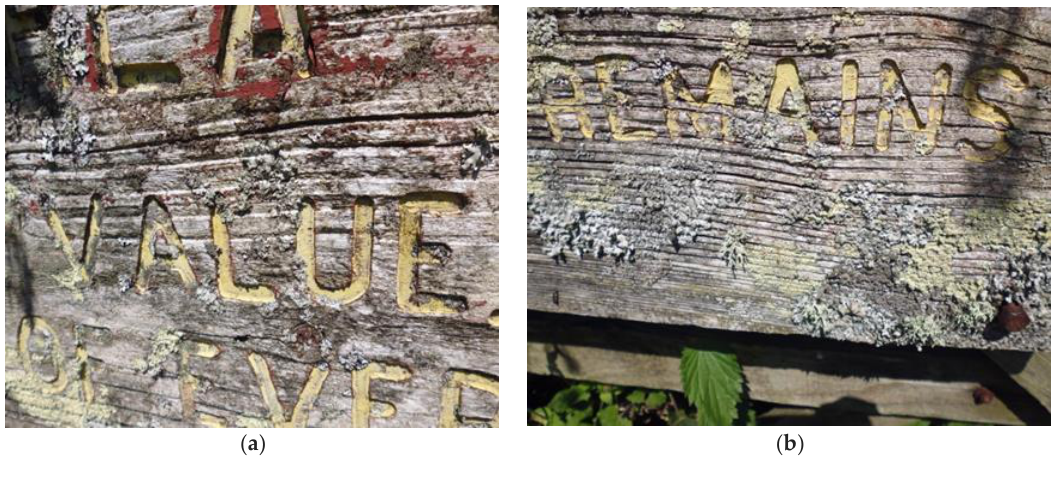
Figure 7. ( a ) Value; ( b ) Remains.